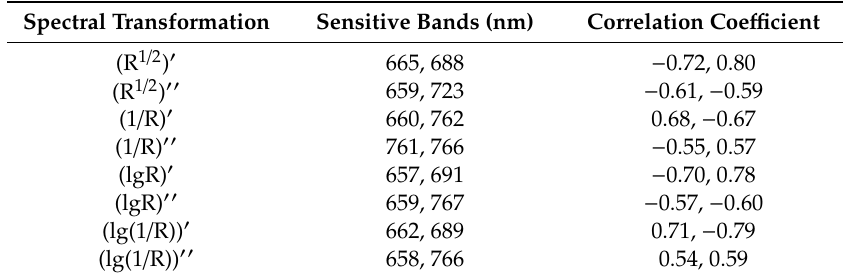
Table 3. Selectionofsensitivebandsandcorrelationcoefficientsunderthedifferentspectraltransformations. Spectral Transformation Sensitive Bands (nm) Correlation Coe ffi